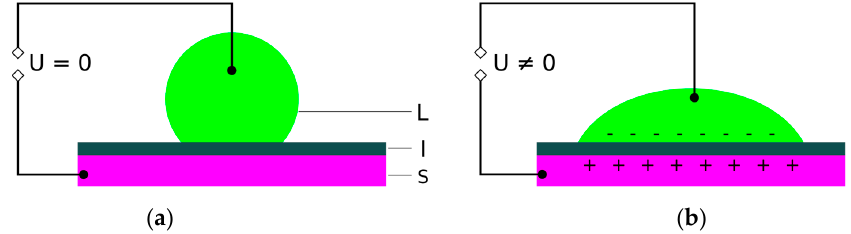
Figure 3. Basic diagram of the electrowetting principle: the change in the solid–electrolyte contact angle due to an applied potential difference between the solid and the electrolyte ( a ) without voltage; ( b ) with applied voltage. (L—Liquid, I—Isolator, S—Substrate, U—Potential). Under CC0 1.0 Universal, public domain dedication.